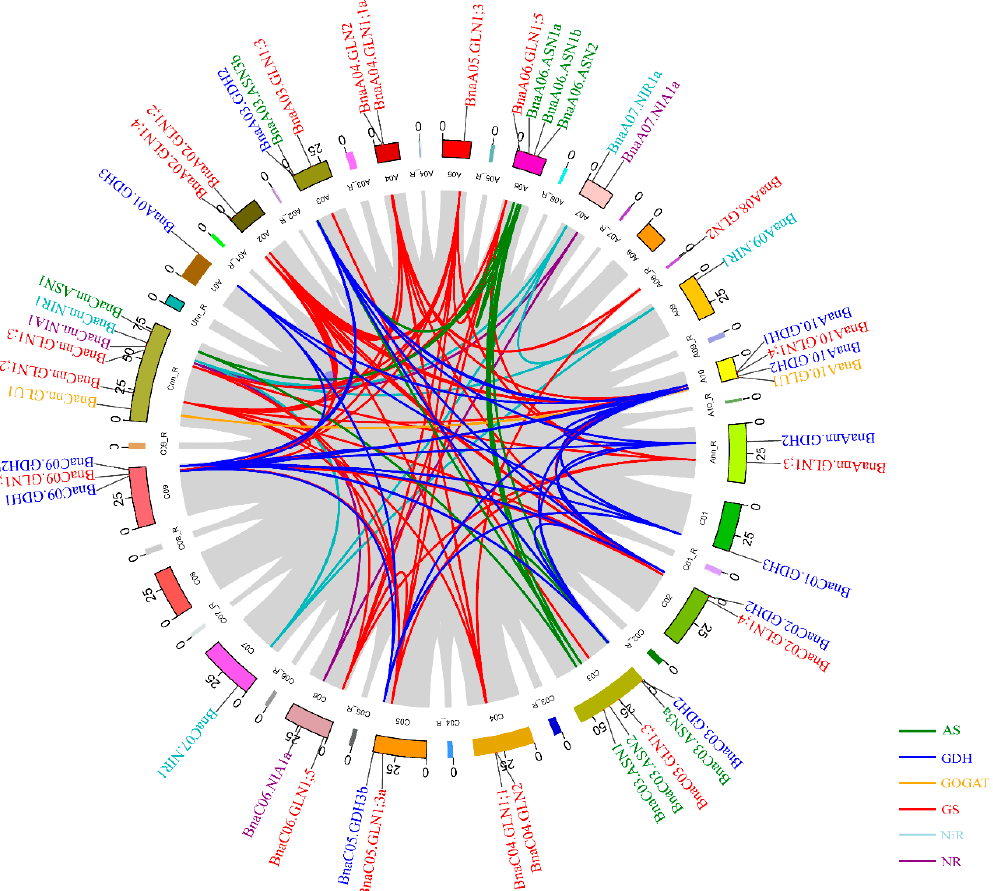
Figure 3. Schematic representations for the chromosomal distribution and interchromosomal relationships of the nitrogen assimilation related genes in Brassica napus . Gray lines indicate all syntenic blocks in the B . napus genome, and the colored lines indicate syntenic gene pairs of different gene families. The chromosome number is shown at the bottom of each chromosome. R, random. The number besides the chromosome indicates the length (Mb) of it.